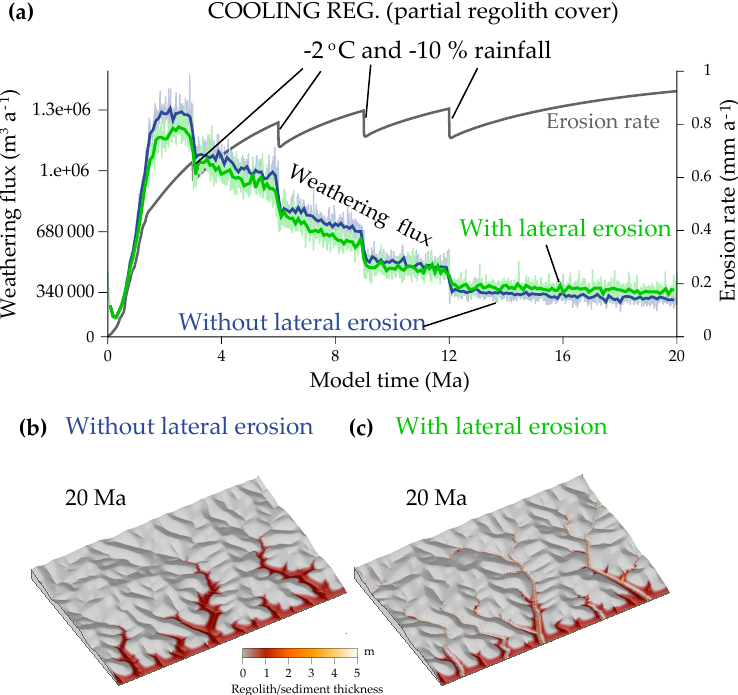
Figure 9. Experiments ending with a regolith covering the low elevations ( < 1500m) and corresponding to a cooling climate. (a) Erosion and weathering flux through time for the models without and with lateral erosion. Panels (b) and (c) show corresponding topography and regolith or sediment thickness at 20Ma for the model with and without lateral